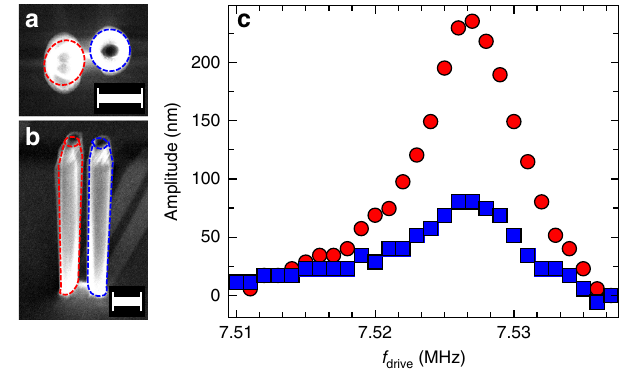
Fig. 2 Hybridized mode. a Scanning electron micrograph of a resonantly ¼ 7 : 527 MHz ) pair of nanopillars ( H (cid:1) 7 μ m , r (cid:1) 310 nm , driven ( f LV d (cid:1) 1 : 3 μ m ) imaged from the top and b , in a 60 (cid:3) tilted view. Red and blue dotted lines indicate the circumference of the undriven left and right resonator, respectively. c Amplitude for different drive frequencies f f of left (red circles) and right (blue squares) resonator determined from LV the scanning electron micrographs. Scale bar in a and b corresponds to 1 μ